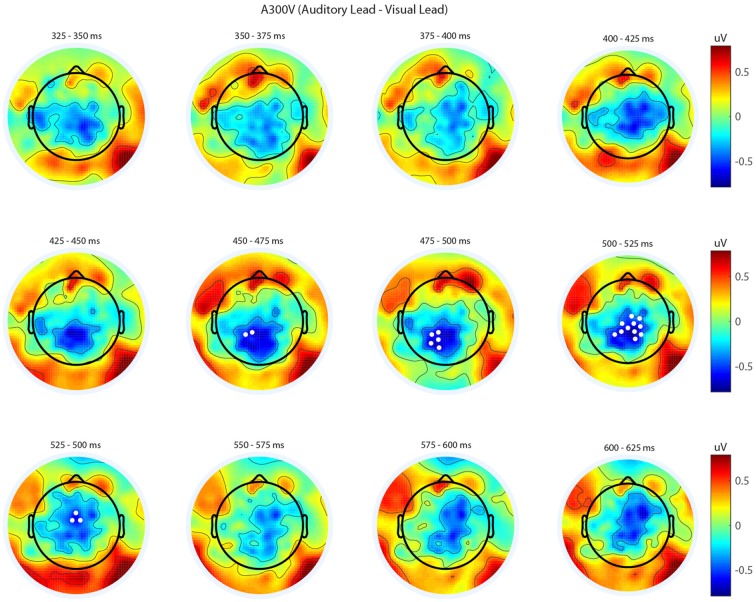
Spatiotemporal representation of evoked differences in the A300V condition. Cluster permutation testing indicated there was a single significant cluster (p = 0.0088). Voltages indicated are the difference between when trial t−1 was auditory leading and when trial t−1 was visual leading. Warm colors indicate voltage was greater when the preceding trial was an audio-leading trial. Cool colors indicate voltage was greater when vision-lead on the preceding trial. White circles indicate the locations of electrodes forming a significant cluster.